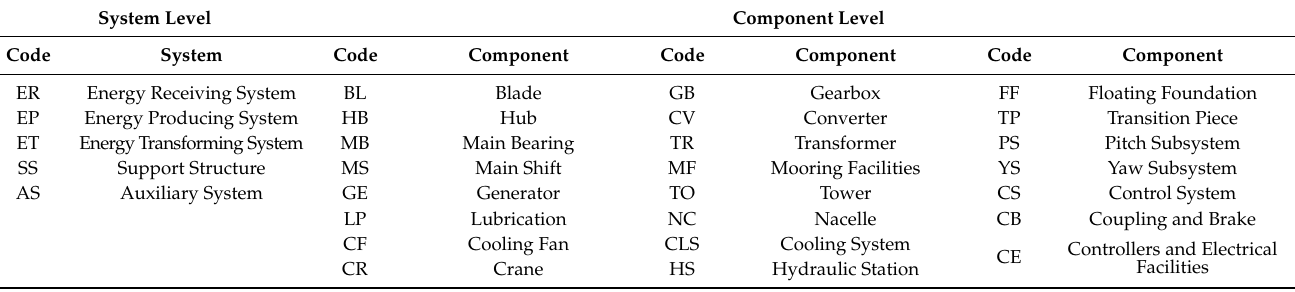
Table 1. Floating offshore wind turbine system